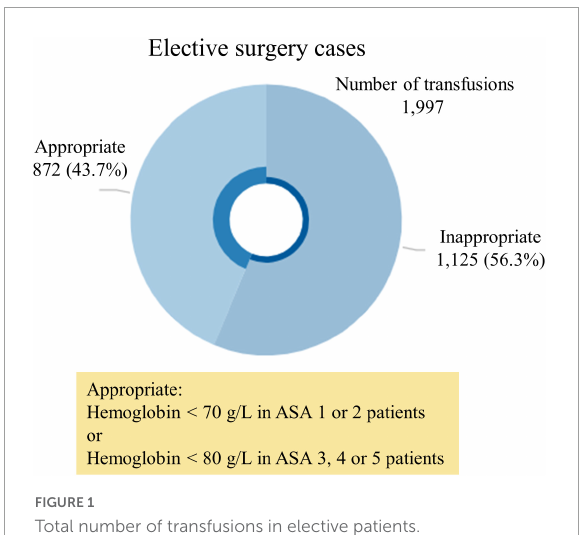
FIGURE1 Total number of transfusions in elective